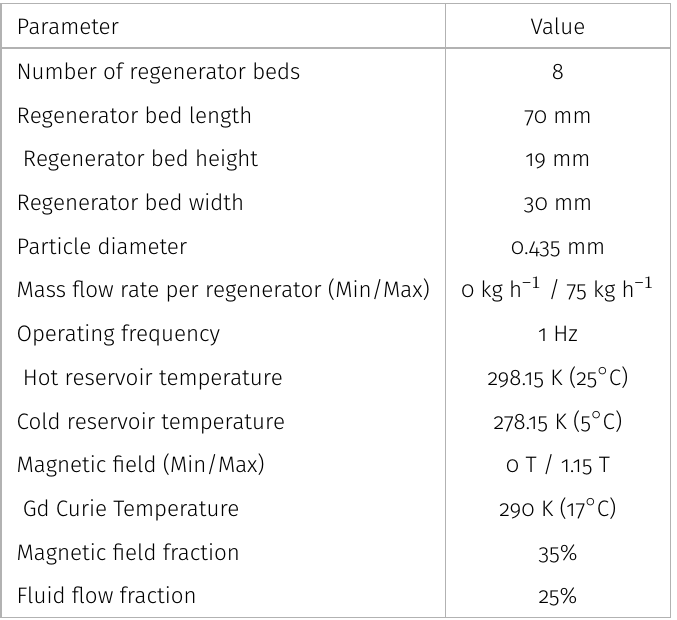
Table V. AMR parameters used in the numerical